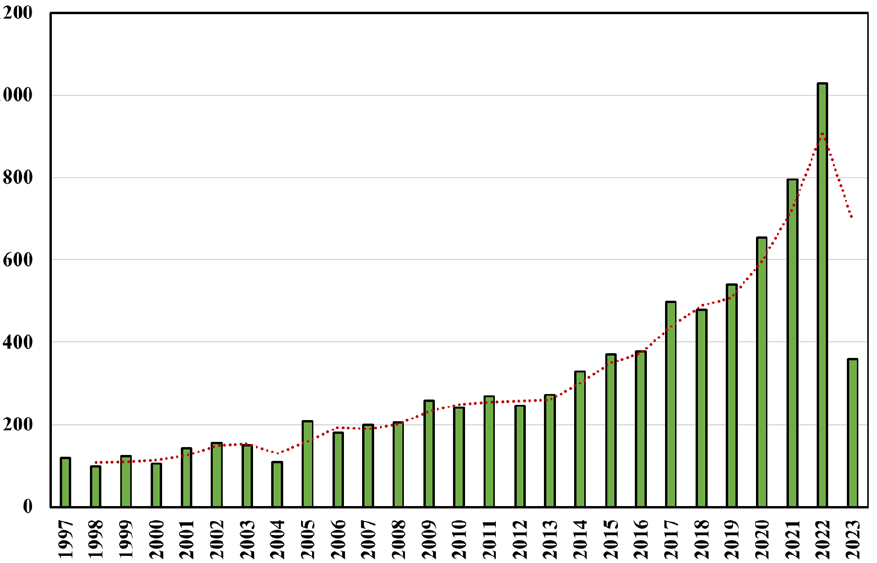
Figure 2. Academic literature database from 1997 to March 2023 extracted from Science Direct with the keyword “Pretreatment for Desalination”.